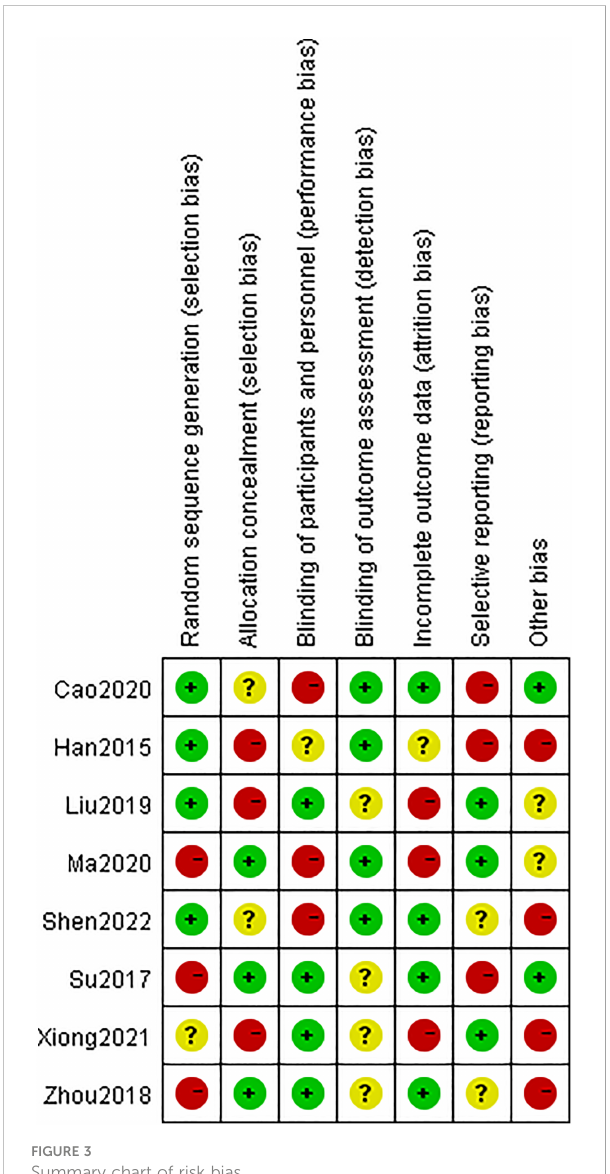
FIGURE 3 Summary chart of risk bias.